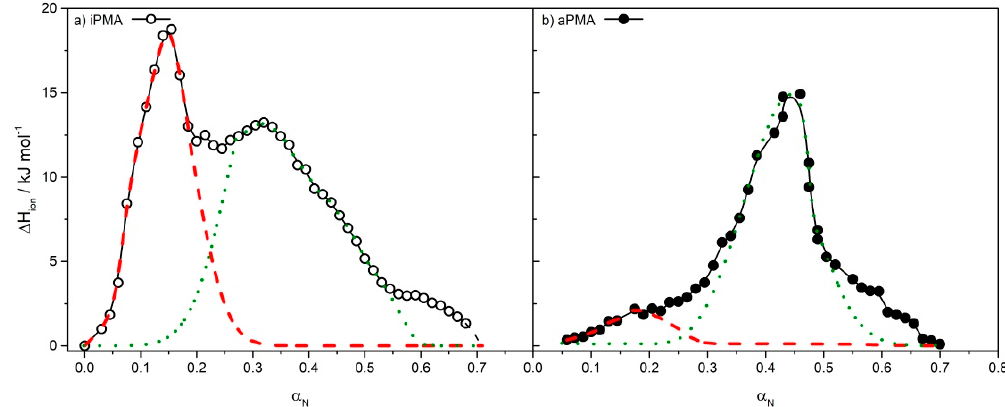
Figure 4. Deconvolution of the calorimetric curves for ( a ) iPMA and ( b ) aPMA in 0.00167 M LaCl 3 at 25 ◦ C. The lines present two superimposed peaks, obtained by deconvolution of the experimental curve, one in the low (red line) and the other one in the high α N region (green line); they represent contributions of the conformational transition ( ∆ H conf ; green dotted line) and intermolecular association ( ∆ H ass ; red dashed line) to the total ∆ H tr value (for details see text).